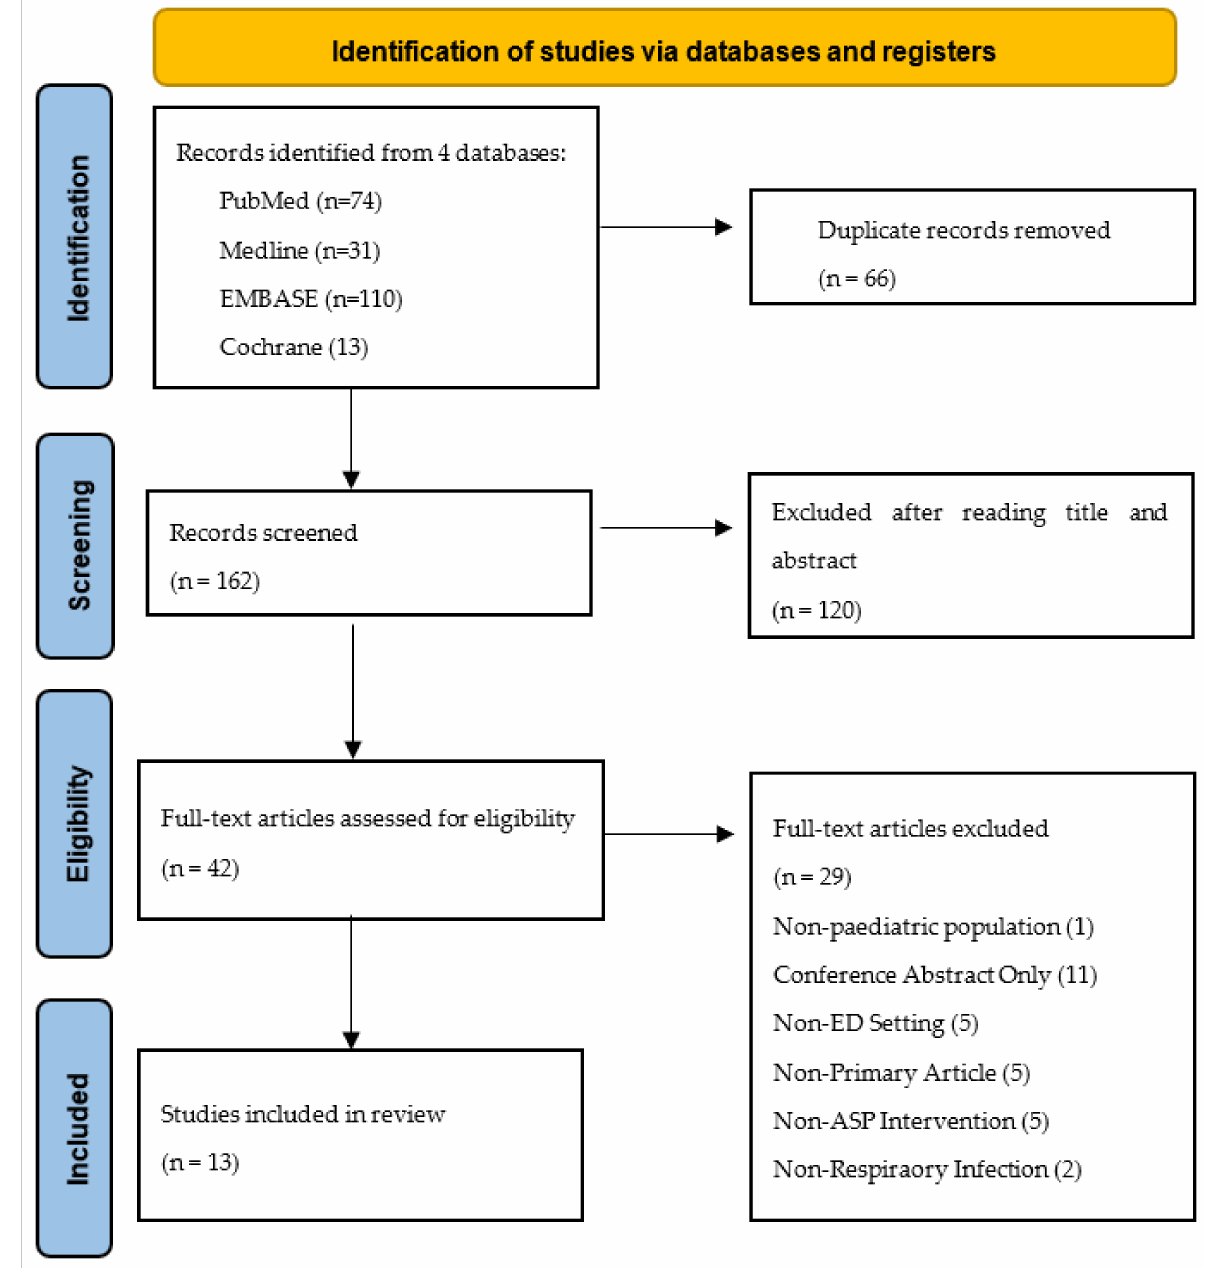
Figure 1. Preferred Reporting Items for Systematic Reviews and Meta-Analysis (PRISMA) flow diagram of study selection